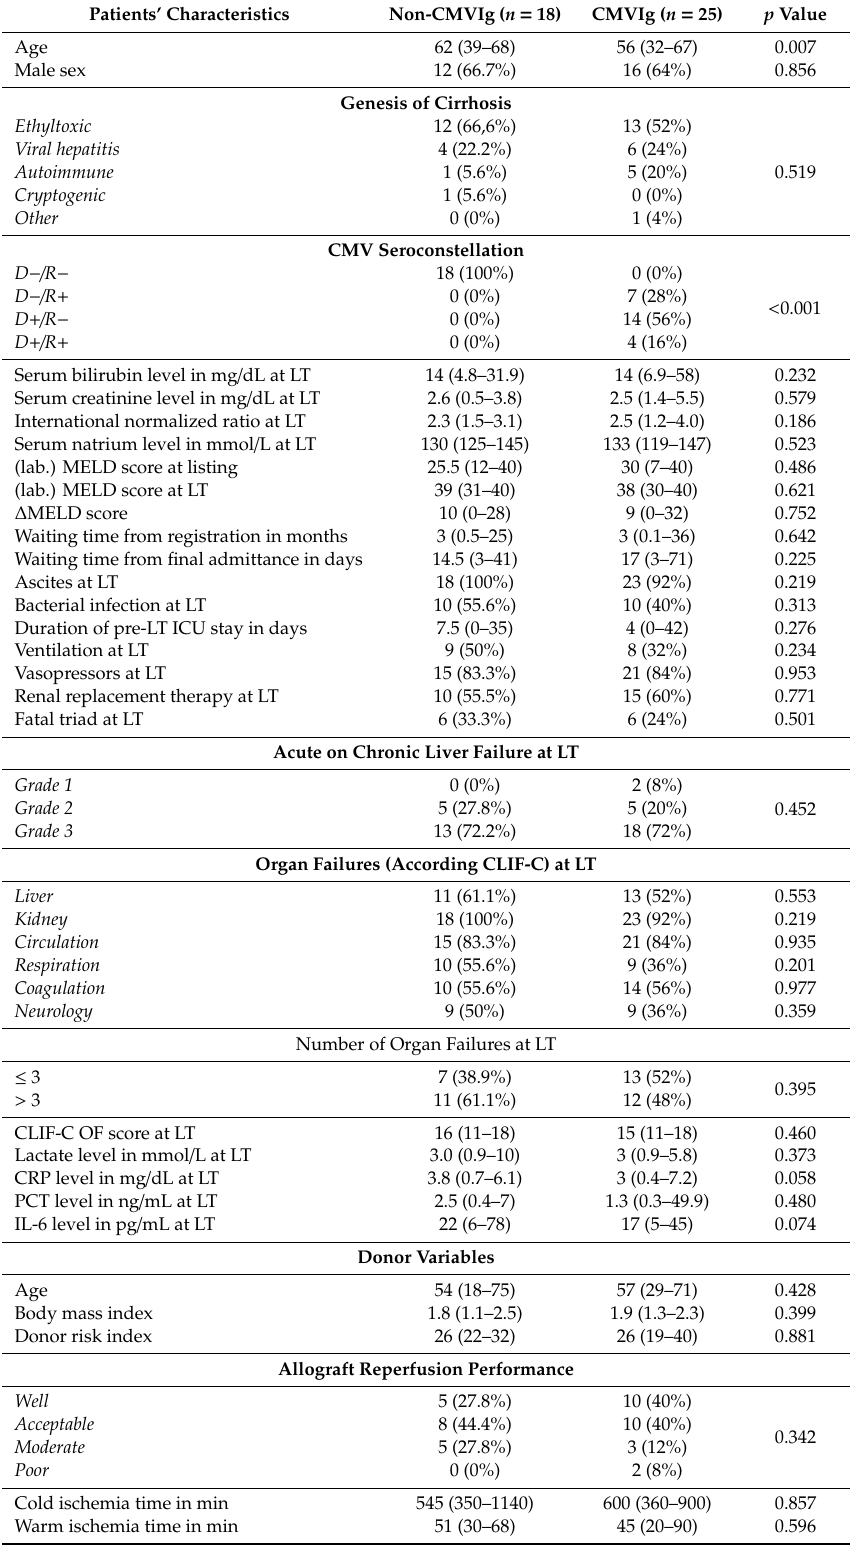
Table 1. Pretransplant patients’ and donors’